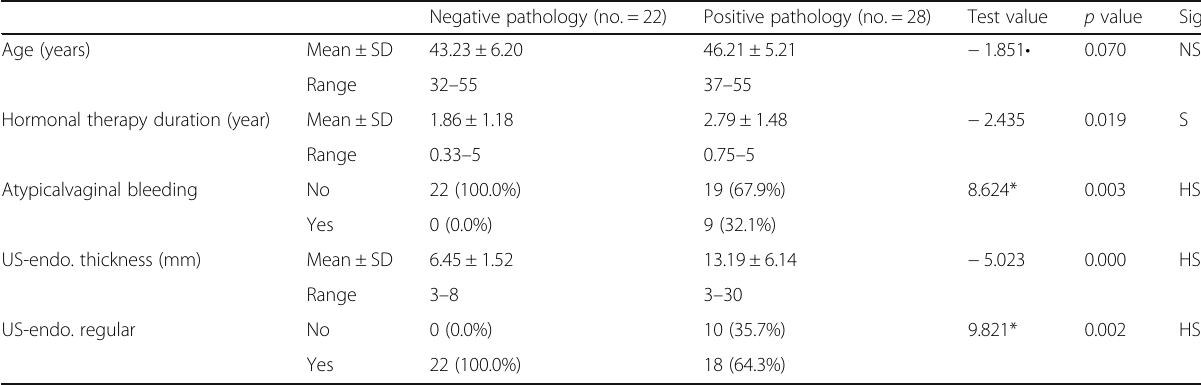
Table 3 Presence of pathology with different variables